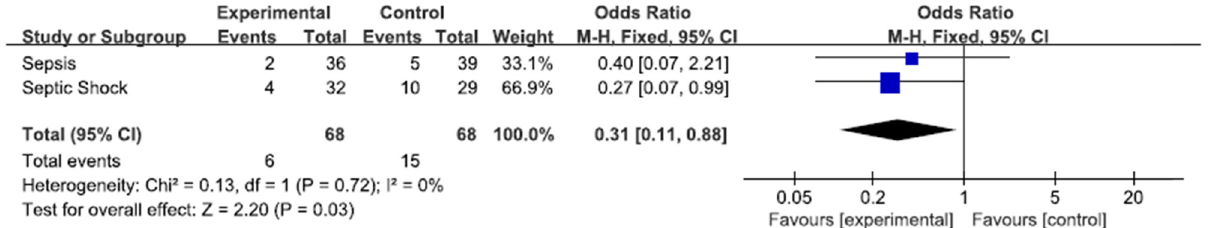
Figure 3: Subgroup analysis of patients with sepsis versus septic shock.